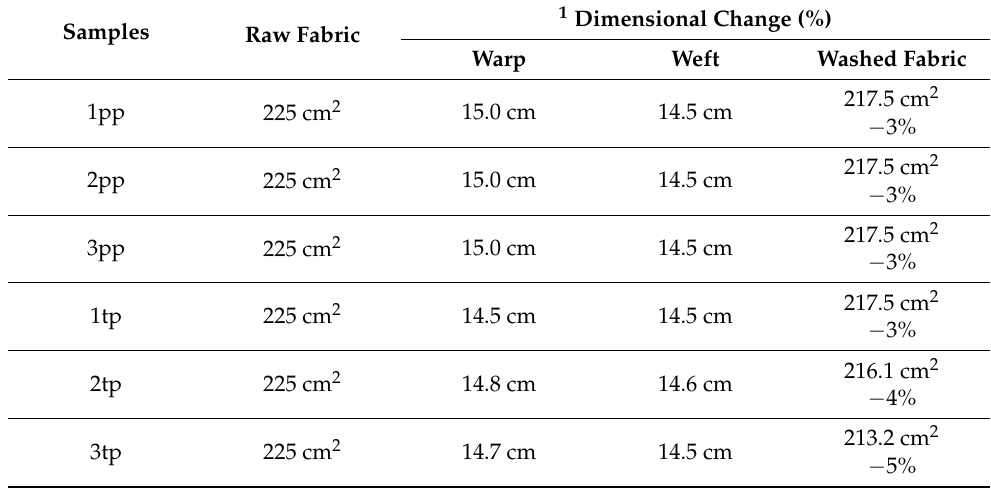
Table 4. Results of dimensional changes.